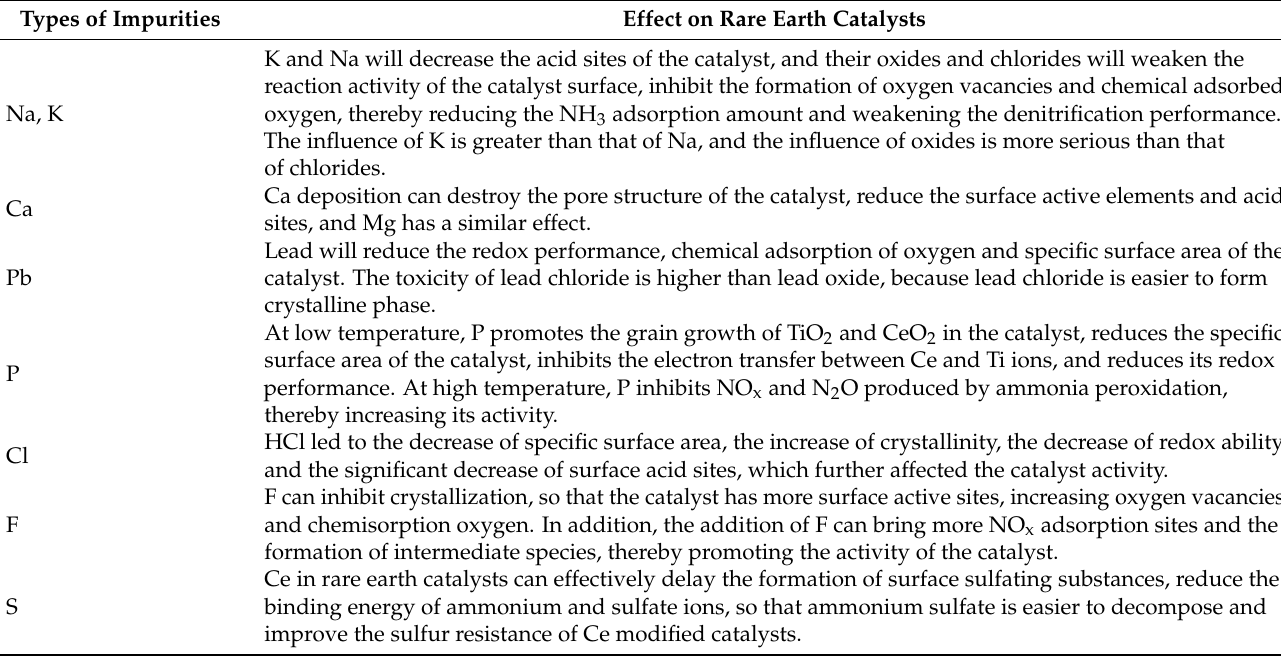
Table 1. Effects of Various Impurities on Rare Earth